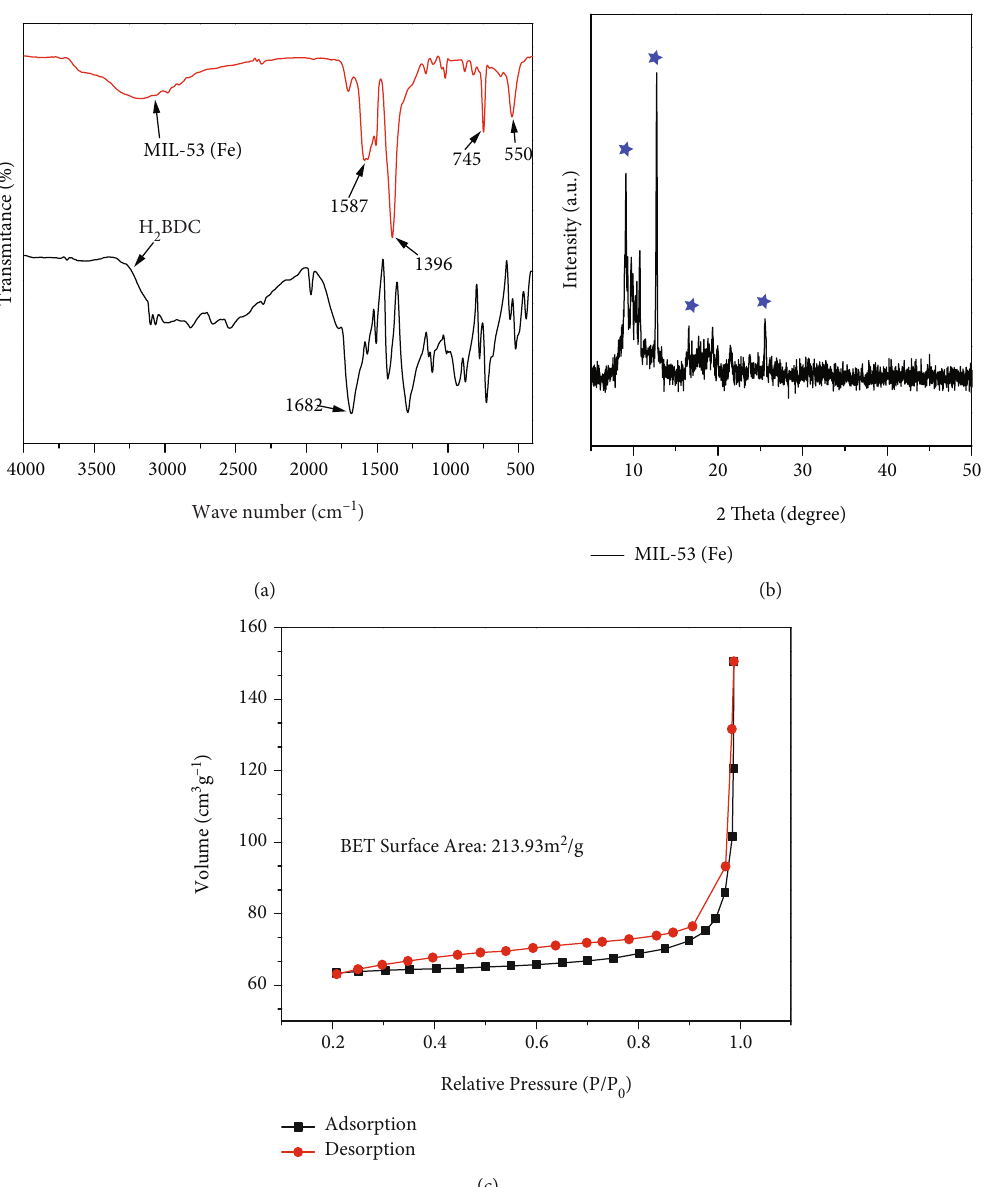
Figure 2: (a) FT-IR spectrum of the as-synthesized MIL-53 (Fe) and H